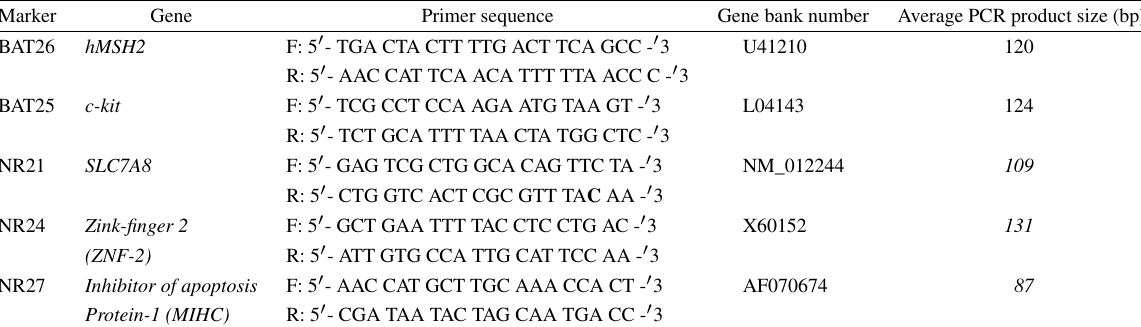
Primers used for microsatellite analysis